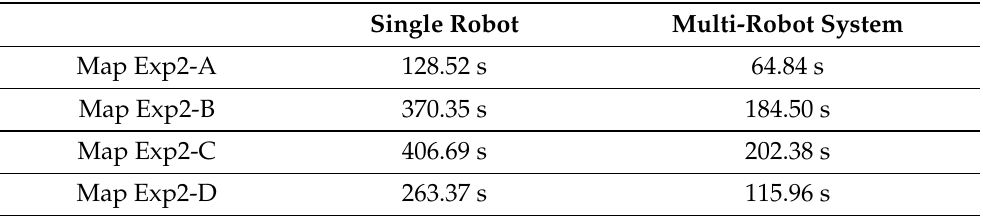
Figure 4. The exploration results with single robot and multi-robot system. Table 2. The exploration time for single robot and multi-robot system on the four maps. The evalua- tion shows the improvement when multiple robots are deployed for the complete